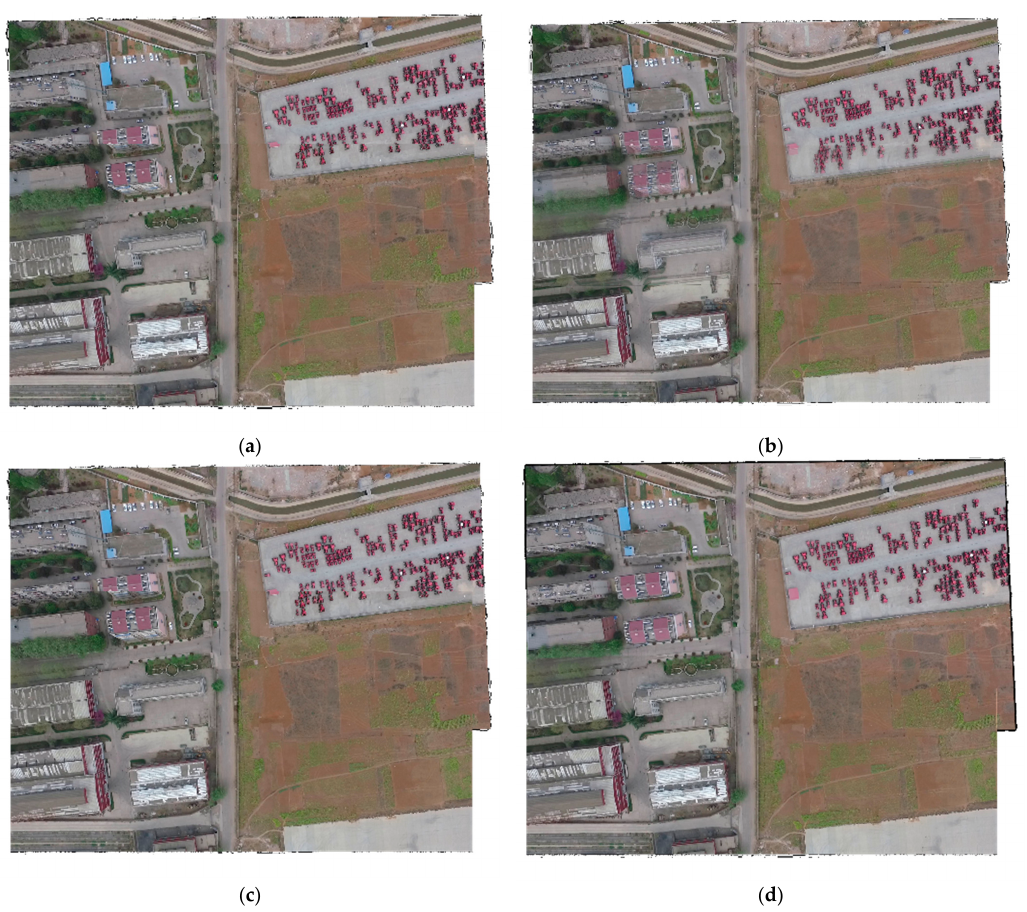
Figure 13. Compositing comparison using different fusion methods. ( a ) Simple coverage. ( b ) Weighted fusion. ( c ) Weight substitution. ( d ) Our method.